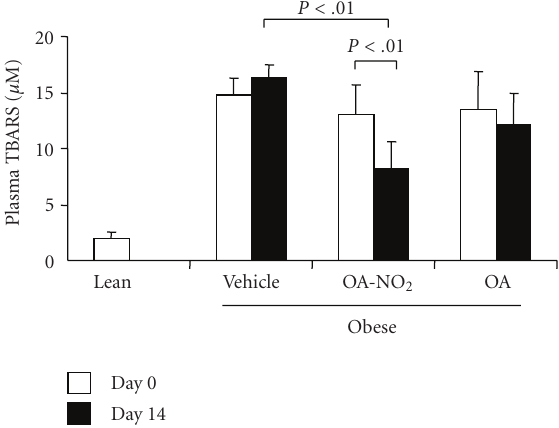
PPAR γ activator as compared with LNO 2 and it also activated PPAR α and PPAR δ at increasing concentrations [3, 4].